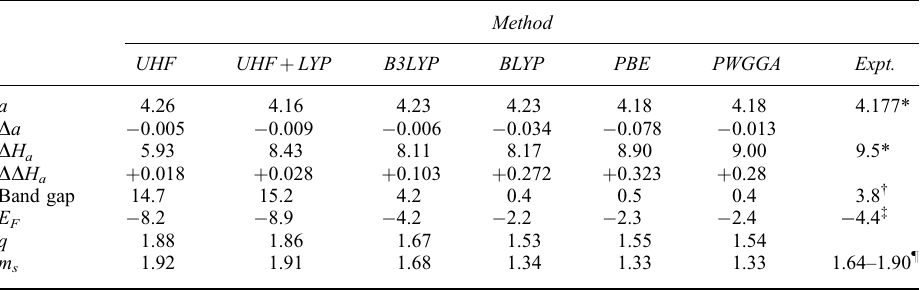
TABLE XII (b) Calculated Bulk Properties for AF 2 Antiferromagnetic NiO: Lattice Constant a , Difference D a to Ferromagnetic State (A˚ ), Heat of Atomization per NiO Unit D H a , Difference to Ferromagnetic State DD H a , Band Gap, Fermi Level E F (eV), Mulliken Charges q (a.u.), and Atomic Spin Moment m s ( m B ).